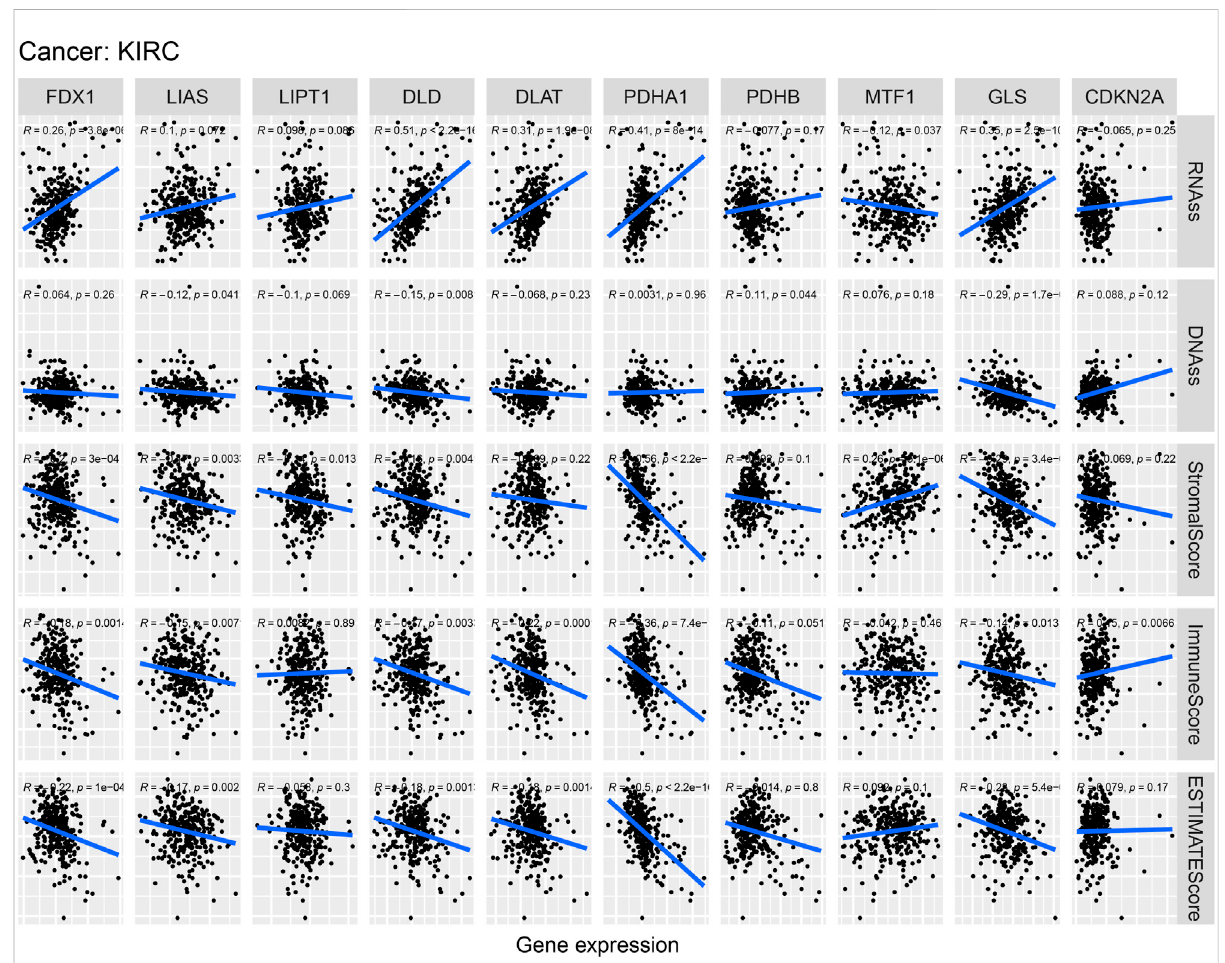
FIGURE 11 Correlation analysis of cuproptosis-associated gene expression, the tumor microenvironment, and stem cell scores in